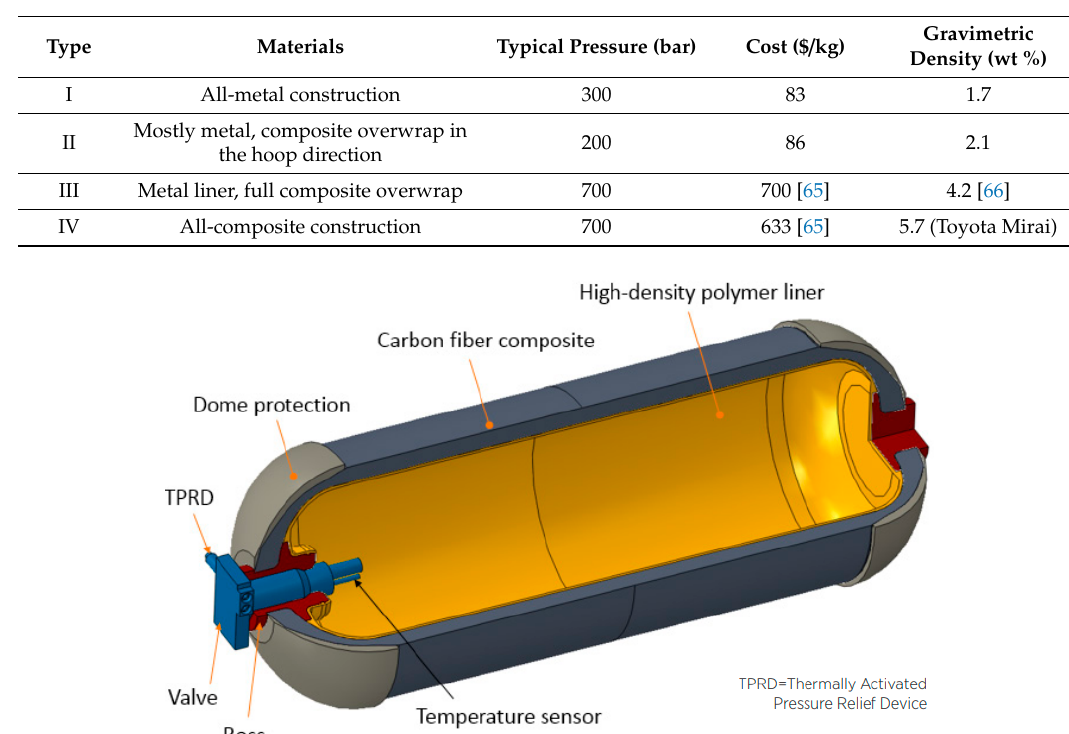
Figure 1. Type-IV composite overwrapped hydrogen pressure vessel (source: Process Modeling Group, Nuclear Engineering Division. Argonne National Lab (ANL)). Reprinted from Ref. [67]; Copyright DOE 2017.